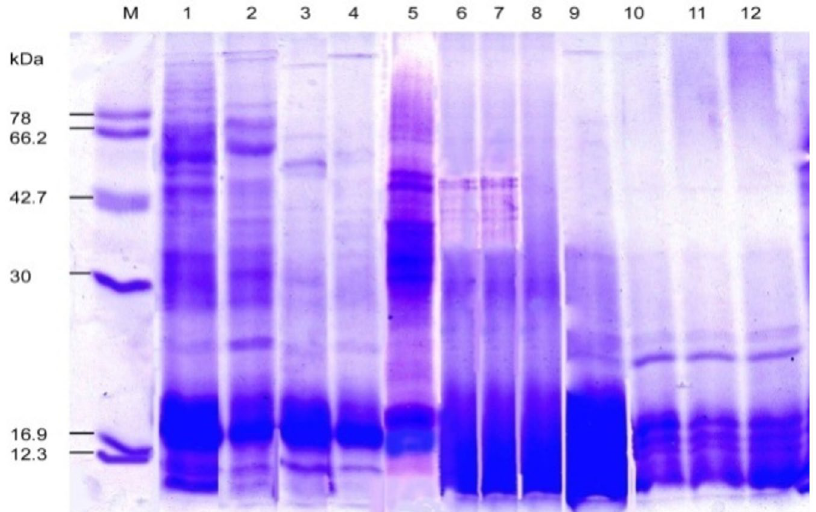
Fig. 7. SDS-PAGE of the protein profiling of threesub-aerial cyanobacteria isolates: Scytonema coactile , Lane 2-4 S . geitleri , Lane 6-8, and Lyngbya aerugineo-coerulea, Lane 10-12 grown in presence of different concentration of calcium carbonate (%) in the medium up to 15 days. An equal amount of proteins were loaded into each well. Control (Lane 1, 5, 9); Molecular mass of standard proteins in